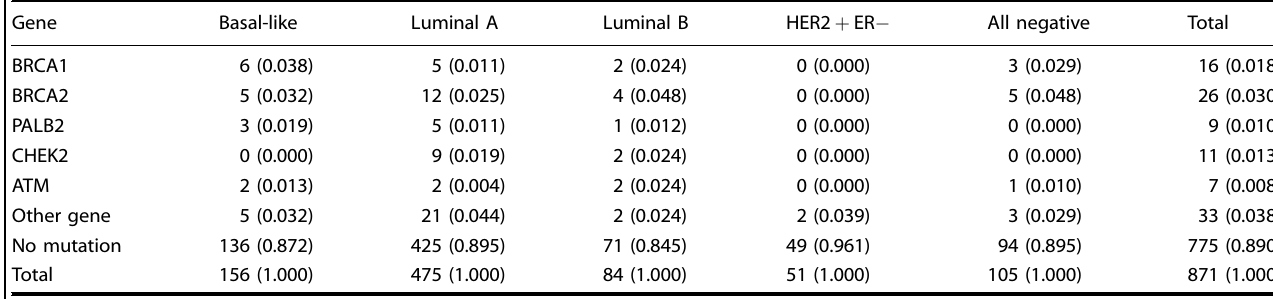
Table 3. Tumor subtypes of CBCS patients a .